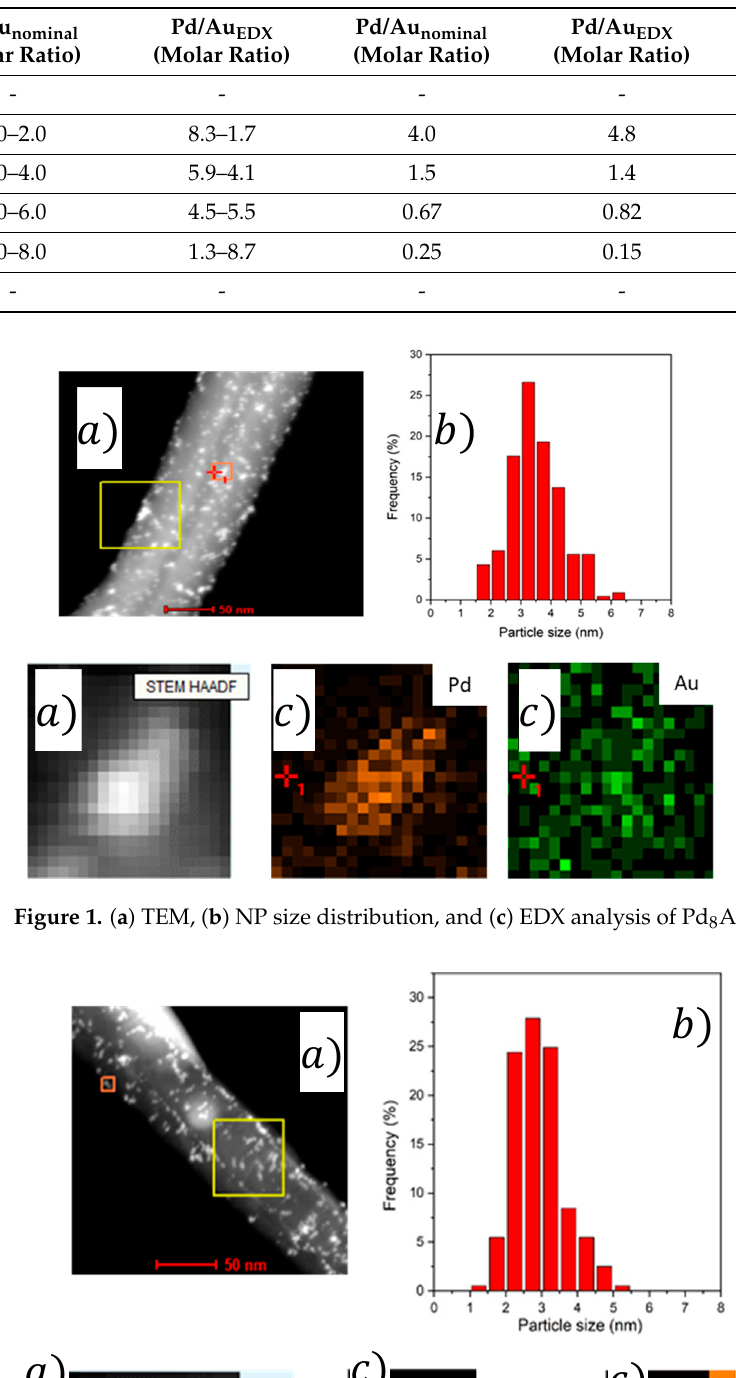
Figure 2. ( a ) TEM, ( b ) NP size distribution, and ( c ) EDX analysis of Pd 6 Au 4 catalyst.